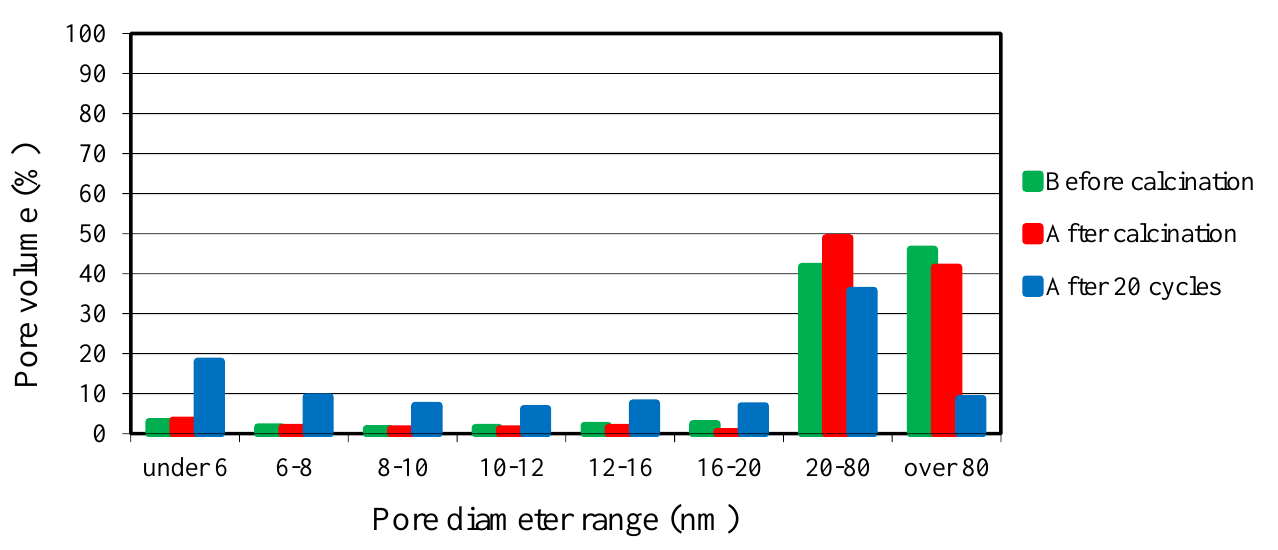
Figure 5. A comparison of Branžovy limestone pore size distribution before calcination, after cal- cination, and after 20 cycles.